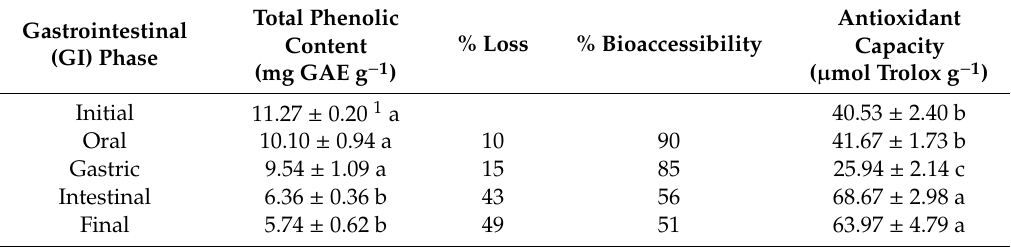
Table 5. Total phenolic compounds (TPC), bioaccessibility, and antioxidant capacity determined in the initial, oral, gastric, intestinal, and final phases during in vitro